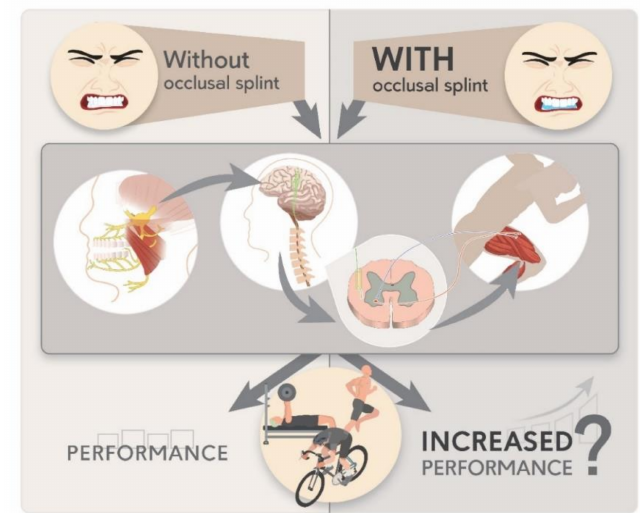
Figure 1. Graphical representation of how changes in dental occlusion (i.e., occlusal splint